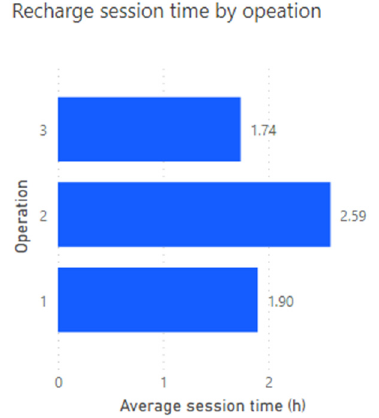
Figure 8. Recharging session time by operation.